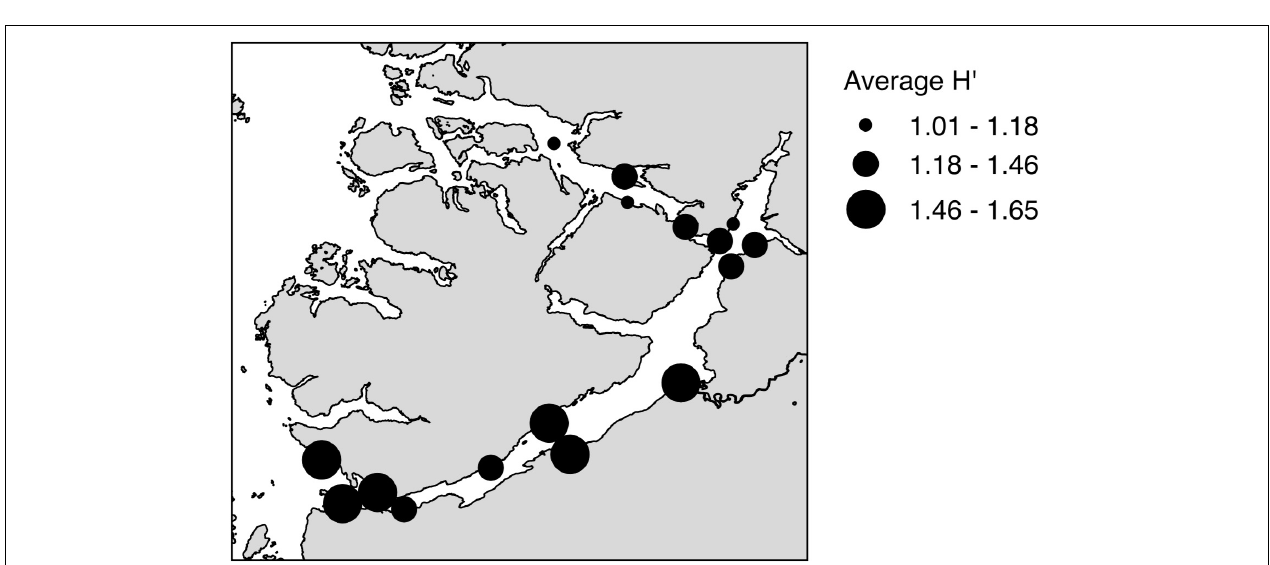
FIGURE 4 | Map representing average Shannon index H (cid:48) for the investigated sites.